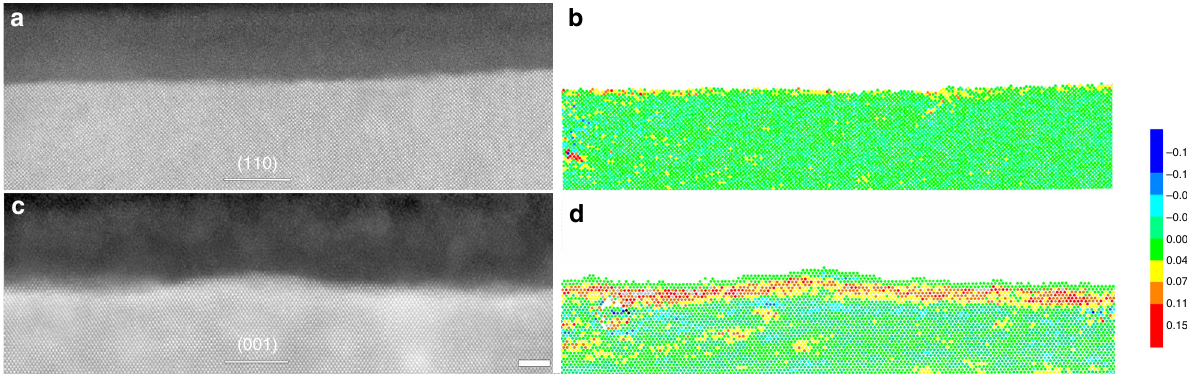
Fig. 6 LADIA simulation results showing the strain state in the matrix side near the metal/passive fi lm interface. Elastic strain component measured from HAADF-STEM image intensity peaks (normal to the interface plane between the passive thin fi lm and the alloy specimen) through the alloy crystal. Scale bar, 2 nm. a High-resolution HAADF-STEM image along the [001] direction of the austenitic matrix showing the passive fi lm on (110) of FeCr 15 Ni 15 single crystal in 0.5 mol L − 1 H 2 SO 4 . The interface is sharp and straight at the atomic scale. b LADIA simulation map based on a , which shows no evidence of lattice expansion and associated tension. The image shows the local expansion/contraction of next-neighbor atom column distances in the alloy along the [110] direction. c High-resolution HAADF-STEM image along the [110] axis showing a passive fi lm formed in 0.5 mol L − 1 H 2 SO 4 + 0.3 mol L − 1 NaCl electrolyte, with corresponding undulating interface. d LADIA simulating map based on c , revealing obvious lattice expansion, with associated induced tension. The image shows the local expansion/contraction of next-neighbor atom column distances in the alloy along the [100] direction. The color bar on the right indicates the normal strain, where colors for positive values represent tensile strain and colors for negative values represent compressive